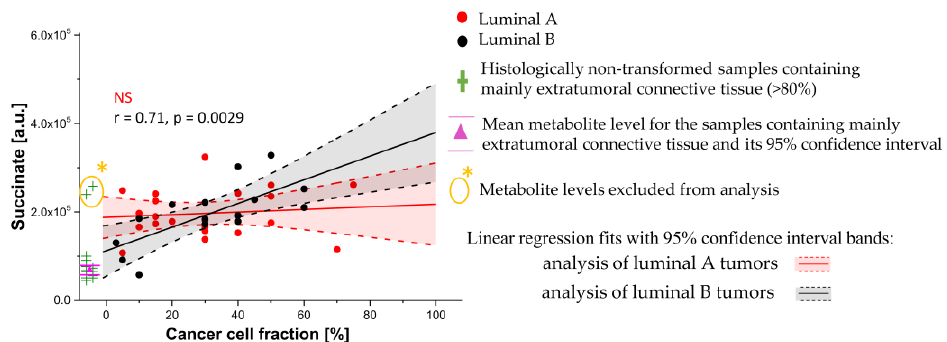
Figure 10. The relationships between a succinate level and a cancer cell fraction in the luminal A and luminal B subgroups. The linear fits (red solid lines—the analysis of luminal A tumors, black solid lines—the analysis of luminal B tumors) with 95% confidence bands (red dashed lines—the analysis of luminal A tumors, black dashed lines—the analysis of luminal B tumors) were calculated for the samples containing mainly intratumoral fibrosis and cancer cells. Pearson correlation coefficients (r) between a succinate level and a cancer cell fraction in luminal B tumors is highlighted in black. The relation for luminal B tumors was not significant (NS, highlighted in